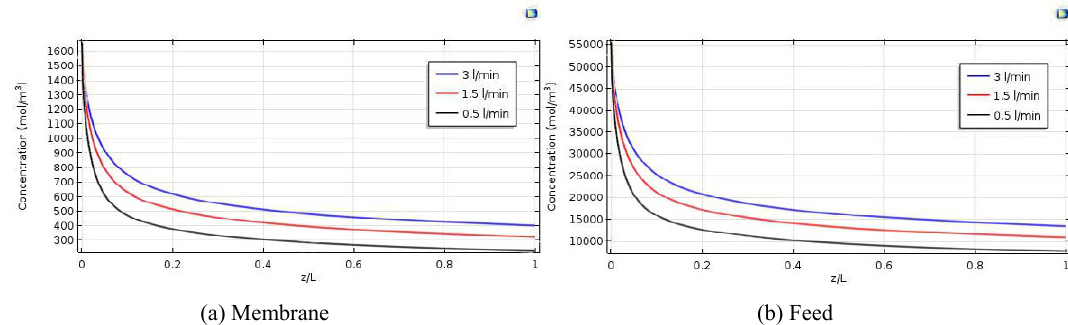
Fig. 11: Water concentration profile vs. membrane dimensionless length at different feed flow rates (60 °C temperature and 1 bar pressure); (a) Membrane section and (b) Feed section